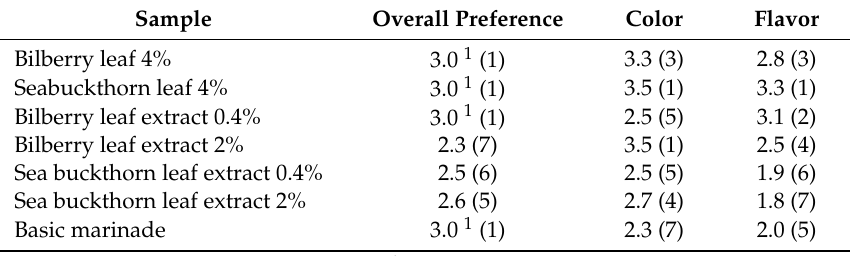
Table 4. Medians of preference scores (rank) of marinated broiler slices ( n =